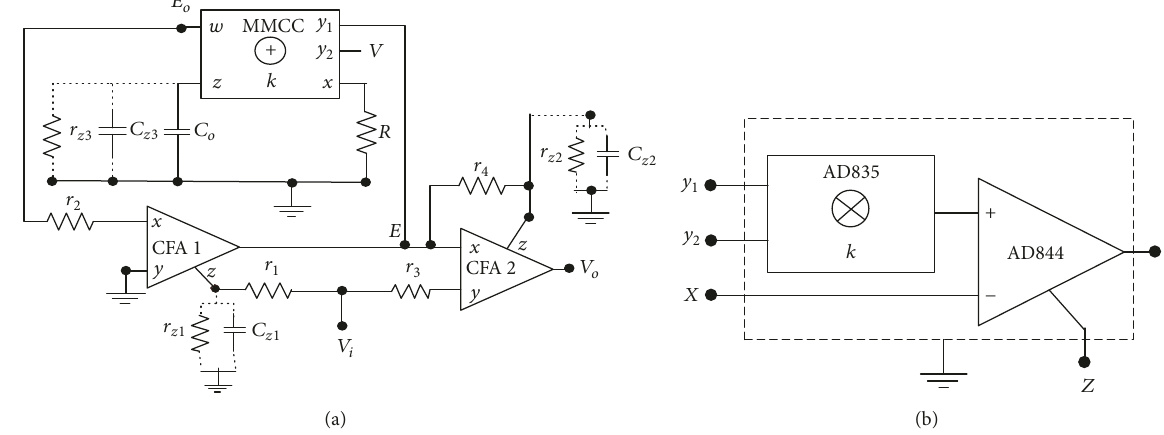
Figure 1: (a) First-order ETAF. (b) Implementation of MMCC with commercially available